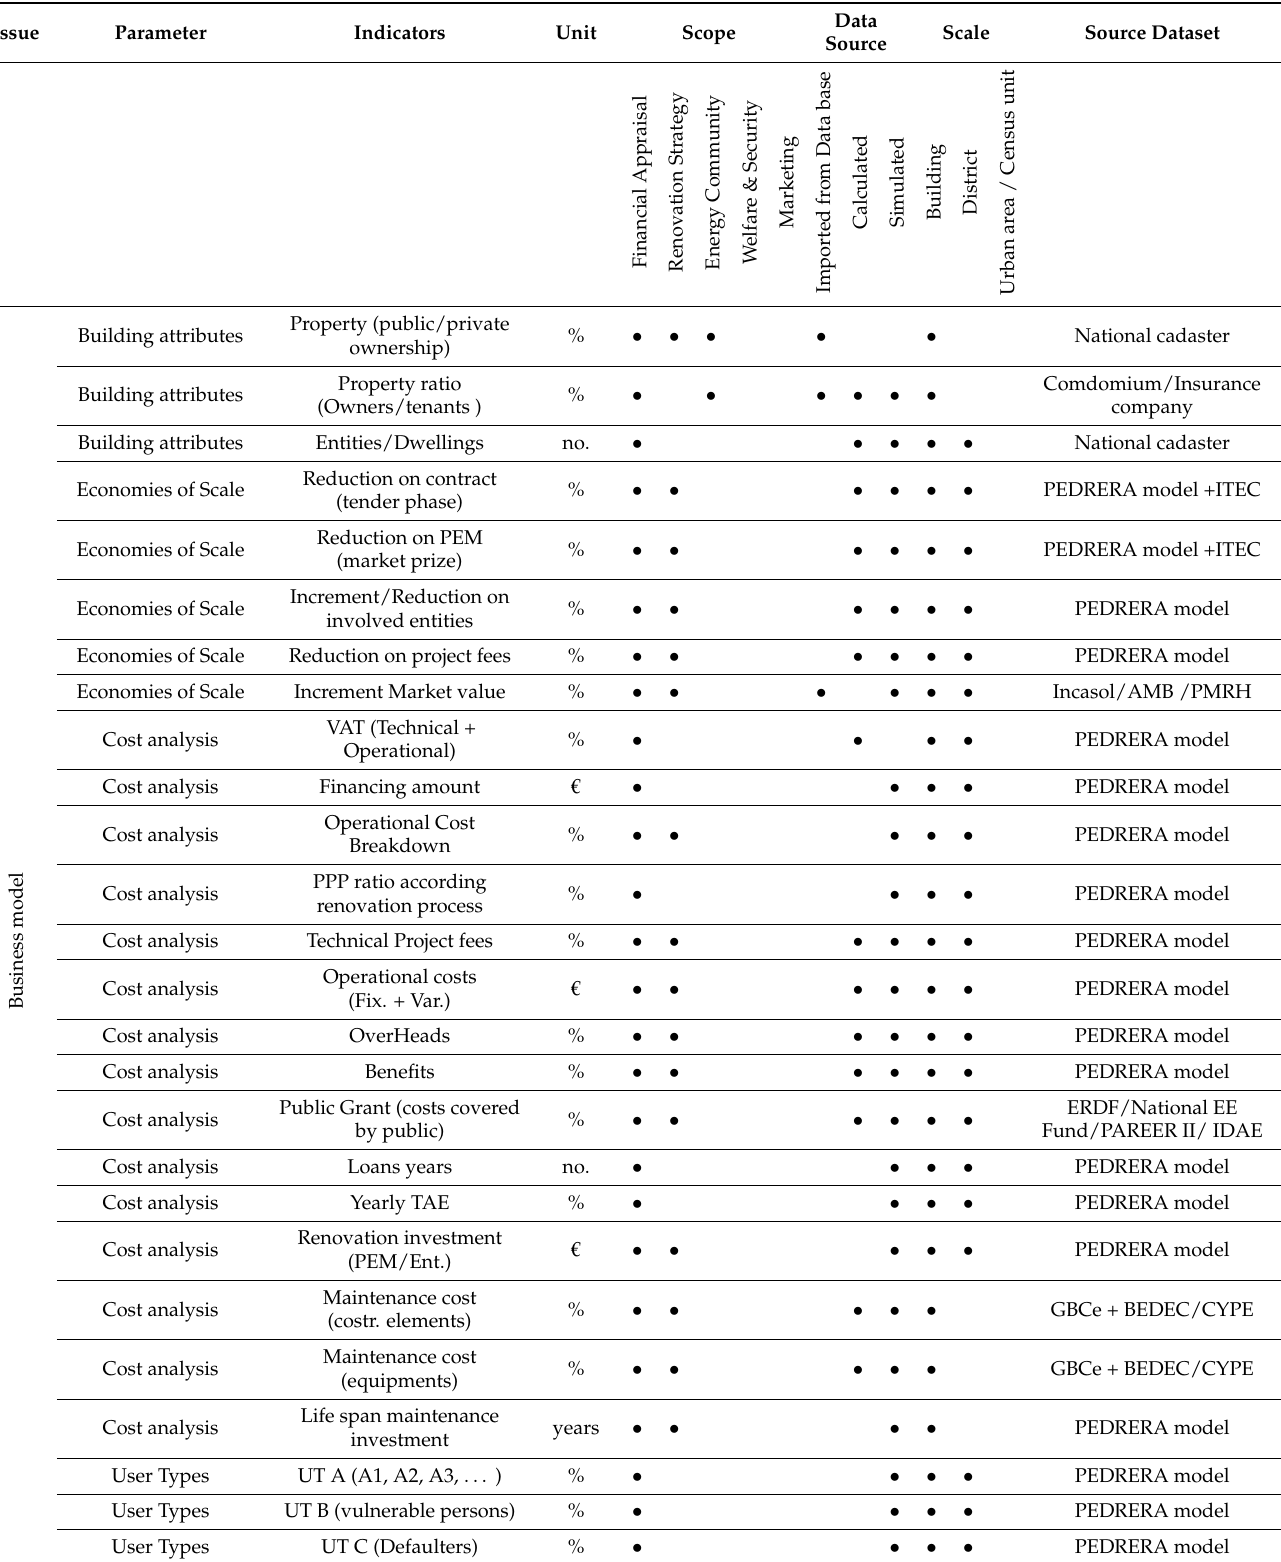
Table 1. List of main input implemented and managed in the PEDRERA model. Source: